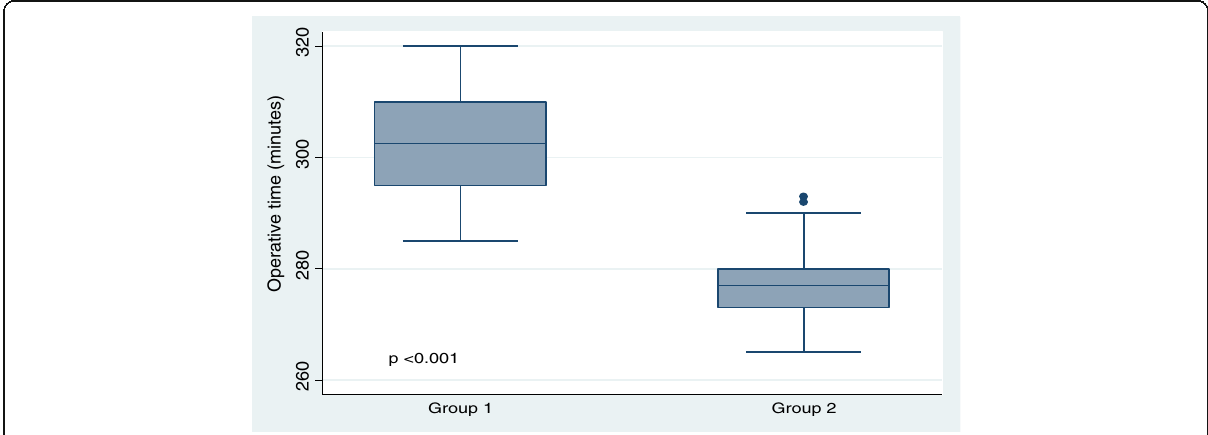
Fig. 4 Comparison of the operative time between both